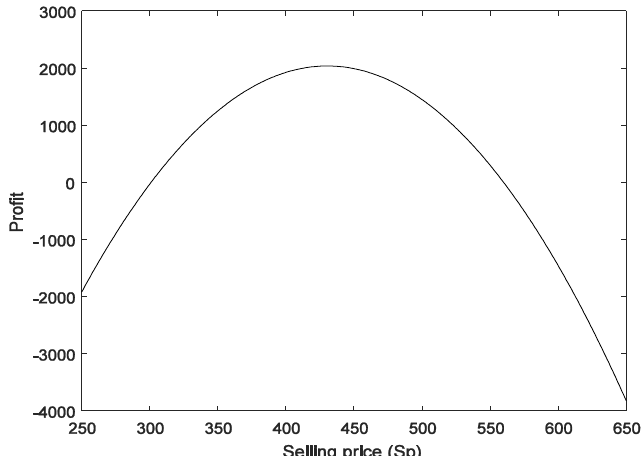
Figure 5. Profit function with regard to s p.